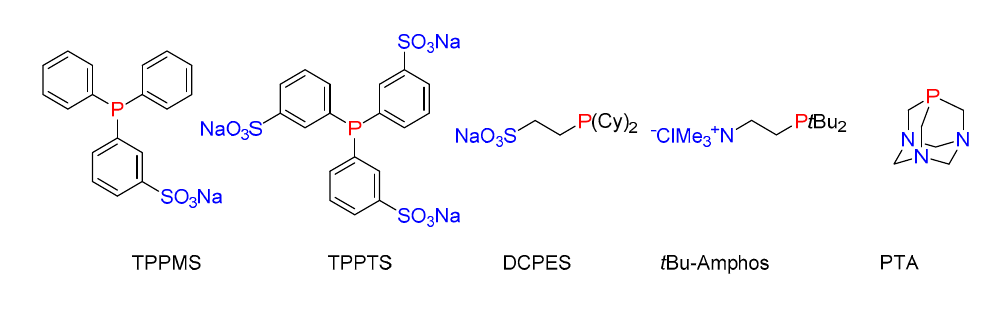
Figure 4. List of water-soluble phosphine ligands.